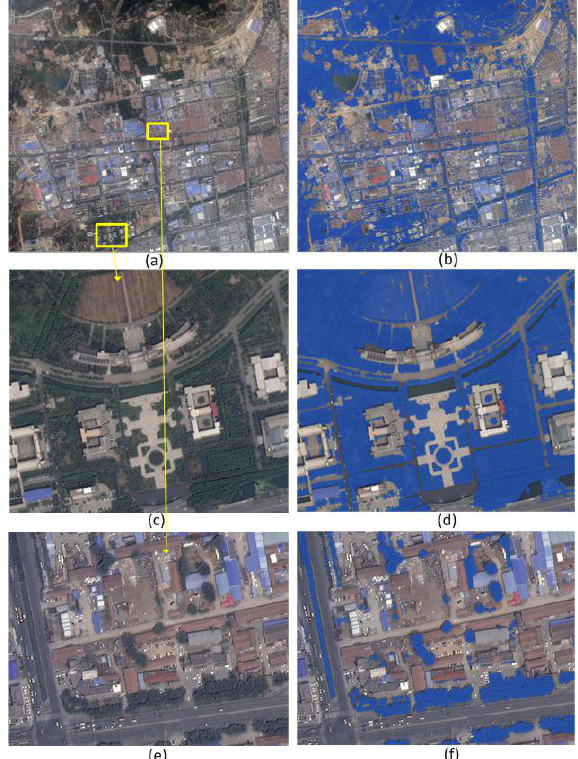
Figure 5. Greenery extraction result of GF-2